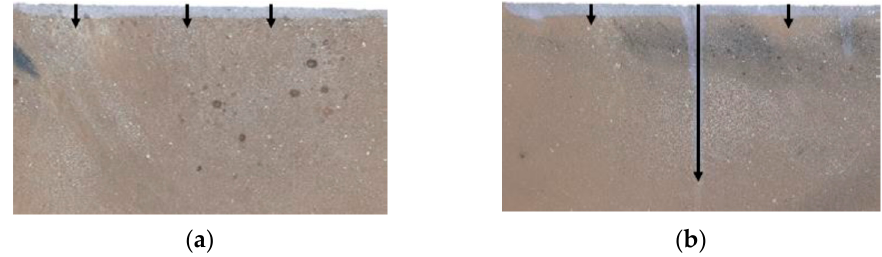
( e ) Figure 7. ( a ) Extraction of a printed CIC beam schematized, (red line indicating the CL), and subse- quent placement of ( b ) a sharpened steel bar ( c ) with the aid of a jig, showing ( d ) final placement of a bar, and ( e ) several reinforced specimens. The beams were fitted with a ponding basin (150 × 160 × 30 mm) on the 20 mm cover face in order to simulate CIC by utilizing a cyclic wetting and drying ponding cycle. A ponding cycle of two weeks (three days of wetting, followed by 11 days of drying) with a 5% sodium chloride (NaCl) aqueous solution was selected to simulate very severe chlo- ride conditions in the marine tidal and splash zones [8,32]. Chloride ponding started at an age of 42 days and the test specimens were kept in the climate-controlled room for a test period of 18 weeks. Corrosion monitoring was performed using the GECOR-10 Sensor A, which is a potentiostat-galvanostat system that uses the galvanostatic pulse technique to measure corrosion intensity ( I corr ), corrosion potential ( E corr ) and ohmic resistance ( R ohm ). Measurements were taken one day after the pond was drained (day four of the ponding cycle), and then seven days (day 11 of the ponding cycle) thereafter. After the CCI testing completion, the beams were saw cut in half to inspect the chlo-